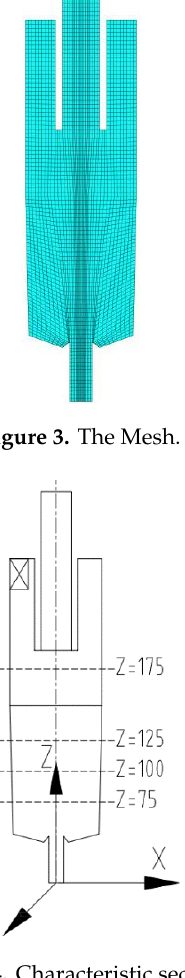
Figure 4. Characteristic sections.